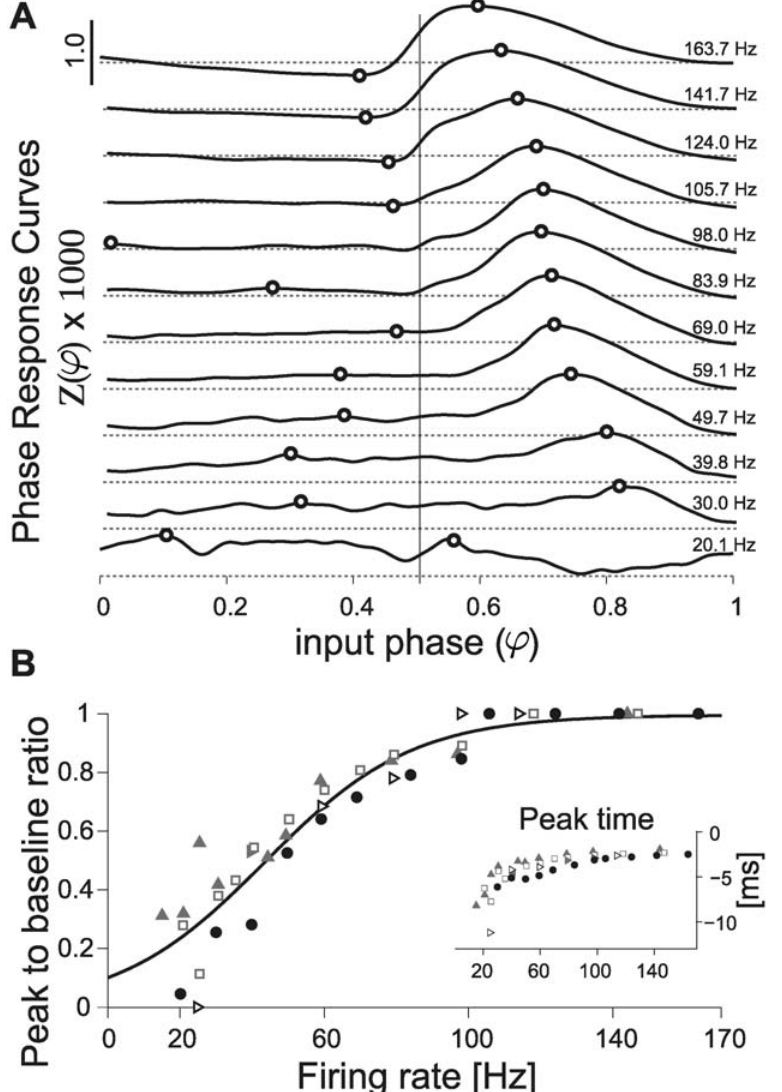
Fig 2. Direct method for the estimation of the PRC. (A) A direct estimate of the PRC, obtained for the same PC, is plotted after data smoothing (see Methods) while altering the cell ’ s firing rate in the range 20 − 160 Hz): a strong dependency on the firing rate is apparent. The transition from an approximately flat to a phase-dependent PRC profile does not occur abruptly, but smoothly: in each subplot, the horizontal gray dashed lines represent Z ( φ ) = 0, while the continuous black thick traces are the PRCs, estimated at distinct firing rates (Fig. 1). Black circles indicate the location of the extrema for each of the two halves of the curves (i.e., in φ 2 [0; 0.5] or [0.5; 1], emphasized by the vertical thin black line), used to concisely characterize the PRC shape according to its peak-to-baseline ratio (see Methods). The graded PRC shape dependency on the firing rate is confirmed in three other PCs (B, markers) and quantified by their peak-to-baseline ratio. The black curve represents the function (1 + e − ( F − a )/ b ) − 1 , with best-fit parameters a = 44.1, b = 20.5. The inset further displays the location of the PRC peak, relative to the time of the AP following the stimulus (i.e., τ peak = ( τ peak − 1) (cid:1) h ISI i ), for the same five cells.